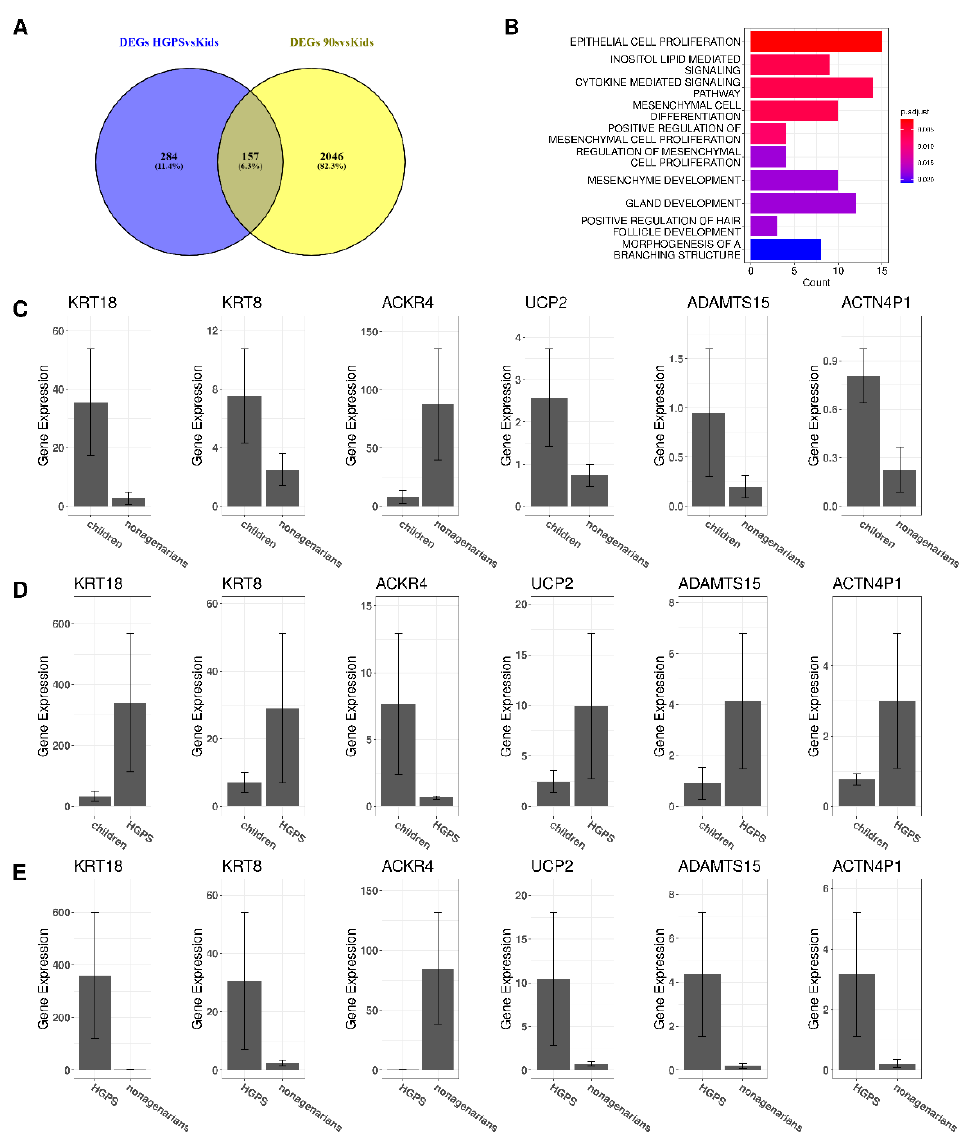
Figure 3. Comparison of accelerated and natural aging. ( A ) Common DEGs in accelerated aging (DEGs between HGPS patients and healthy children, blue) and normal aging (DEGs between nona- genarians and healthy children, yellow) are visualized as Venn diagram. ( B ) The ten most enriched biological processes with GO enrichment using the common DEGs of aging and HGPS (overlap in A). ( C ) Gene expression of the six genes regulated in opposite directions, differences in gene expression between children and nonagenarians. ( D ) Gene expression of the six genes regulated in opposite directions, differences in gene expression between children and progeria patihass. ( E ) Gene expression of the six genes regulated in opposite directions, differences in gene expression between progeria patients and nonagenarians.